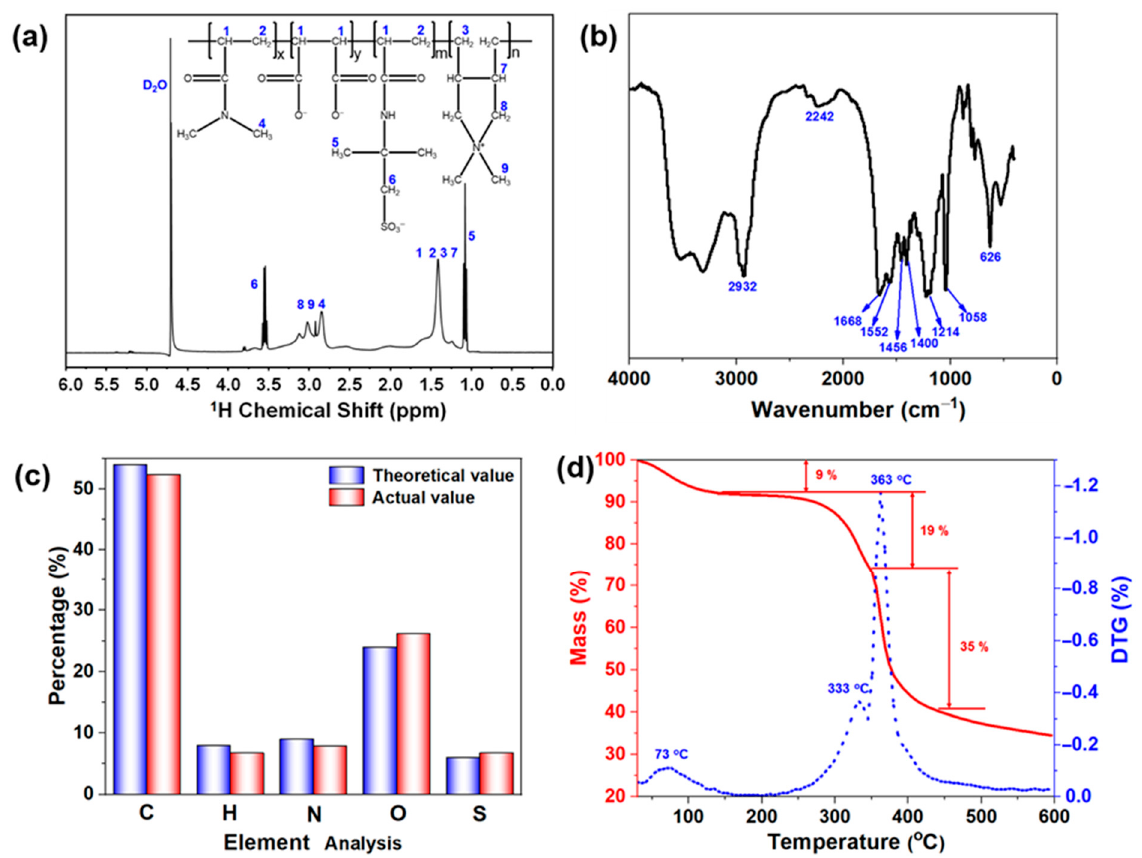
Figure 2. ( a ) 1 H NMR curves of DDAM. ( b ) FTIR spectrum of DDAM. ( c ) Elemental analysis of DDAM. ( d ) TGA and DTG curves of DDAM.